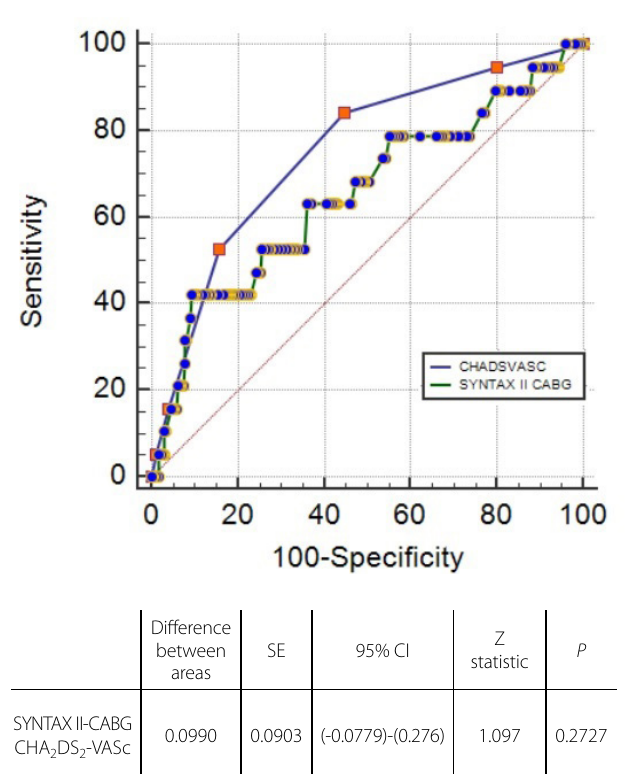
Fig. 2 – Pairwise comparison of receiver-operating characteristic curves of SYNTAX II-CABG and CHA major adverse cardiac event. CABG=coronary artery bypass grafting; CI=confidence interval; SE=Standard error